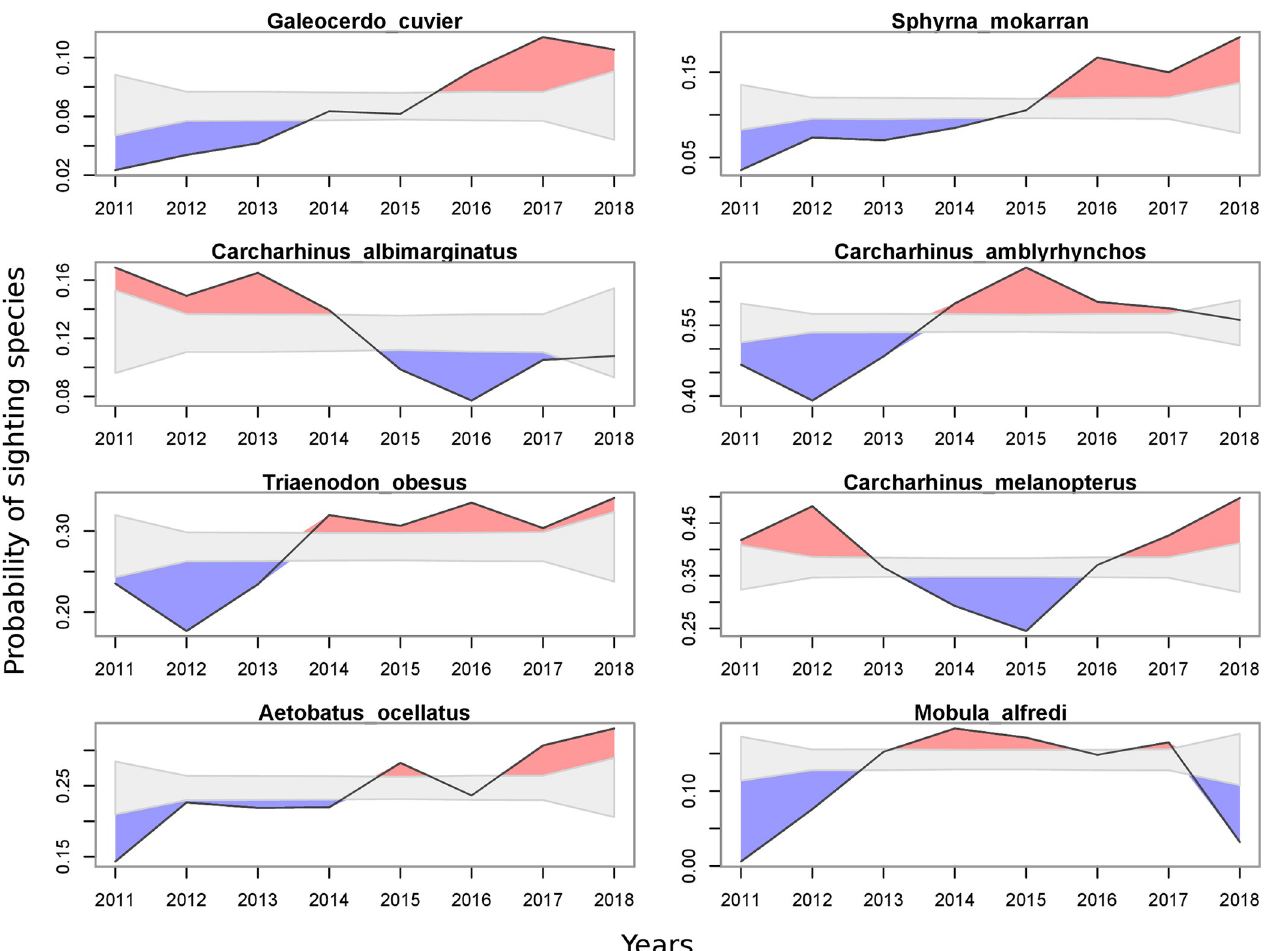
Fig 7. Probability of sighting for eight elasmobranch species frequently encountered throughout French Polynesia between 2011 and 2018. Solid black lines denote observed yearly sighting probability for each species. The gray-shaded polygon indicates the 95% range of the distribution of random sampling. Colored polygons highlight where the observed probability is above (red) or below (blue) the probability of observing that species if they were observed randomly.